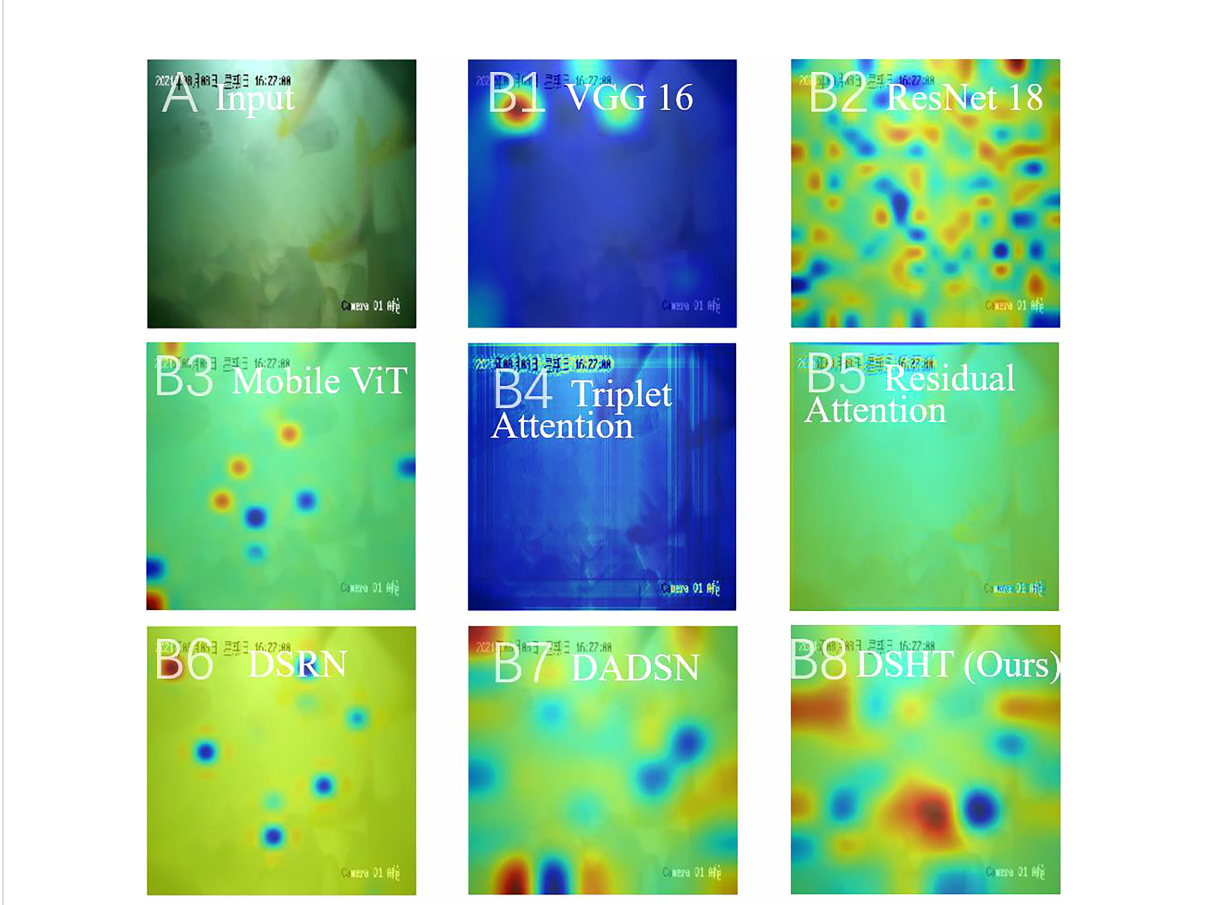
FIGURE 8 Class Activation Map (CAM) of Proposed Method and Other Methods. (A) is the input. From (B1 – B8) , the visualization results of the models in Table 4 are shown